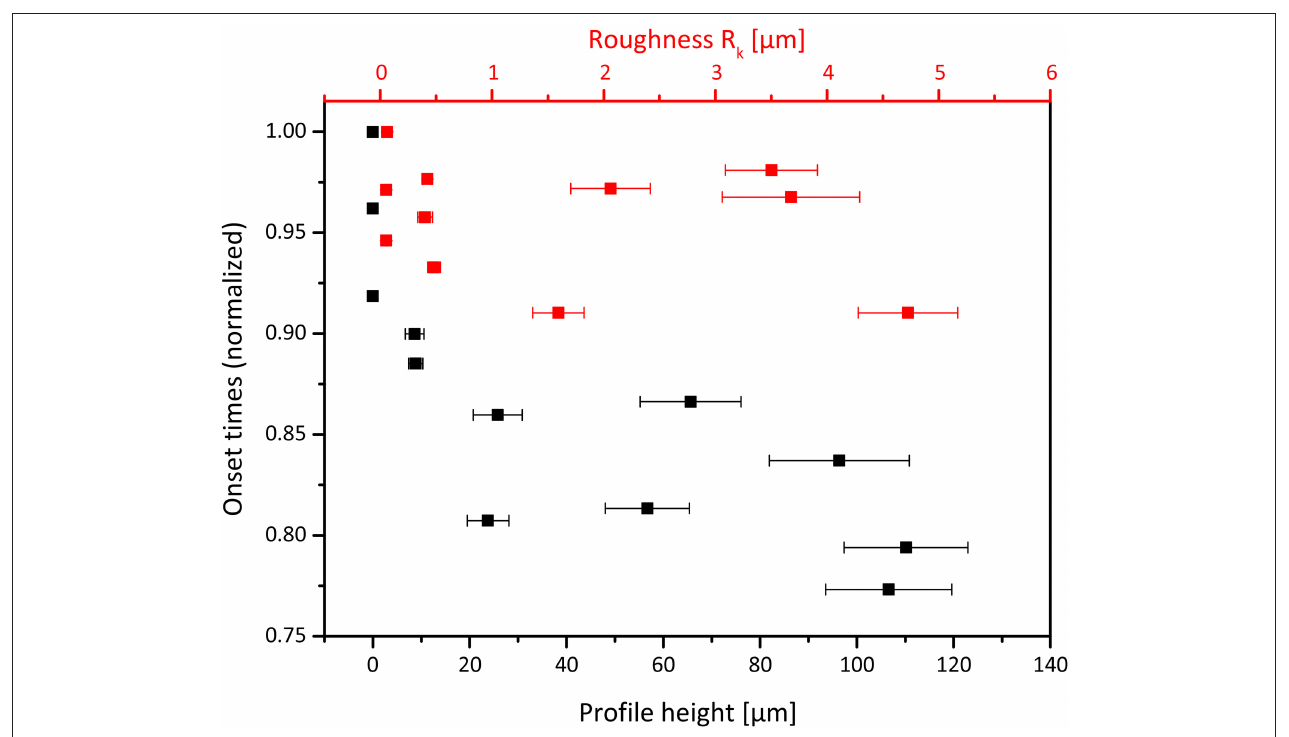
FIGURE 7 | Effect of electrode surface roughness (red) and micro-structures (black) on current onset